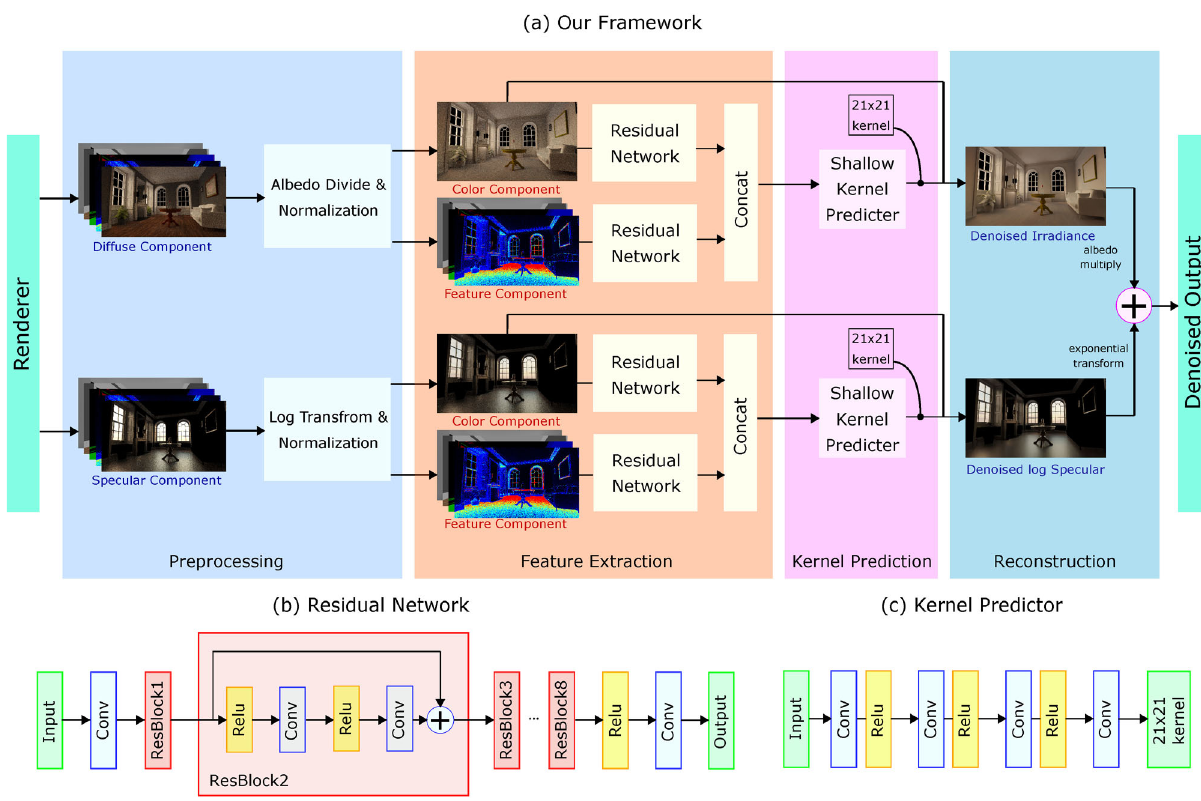
Fig. 3 (a) Framework. The renderer decomposes rendered outputs into diffuse and specular components which are preprocessed independently. In both, their features are separated into a color component and a feature component. These are fed into a residual network receptively to extract features and the extracted features are concatenated. Next, two kernel predictor networks filter the extracted features and output two 21 × 21 kernels, which are used to denoise preprocessed diffuse and specular buffers. Finally, these denoised results are combined to obtain the full denoised image. (b) The residual network architecture, with eight residual blocks. (c) The kernel predictor architecture, with four convolutional layers.